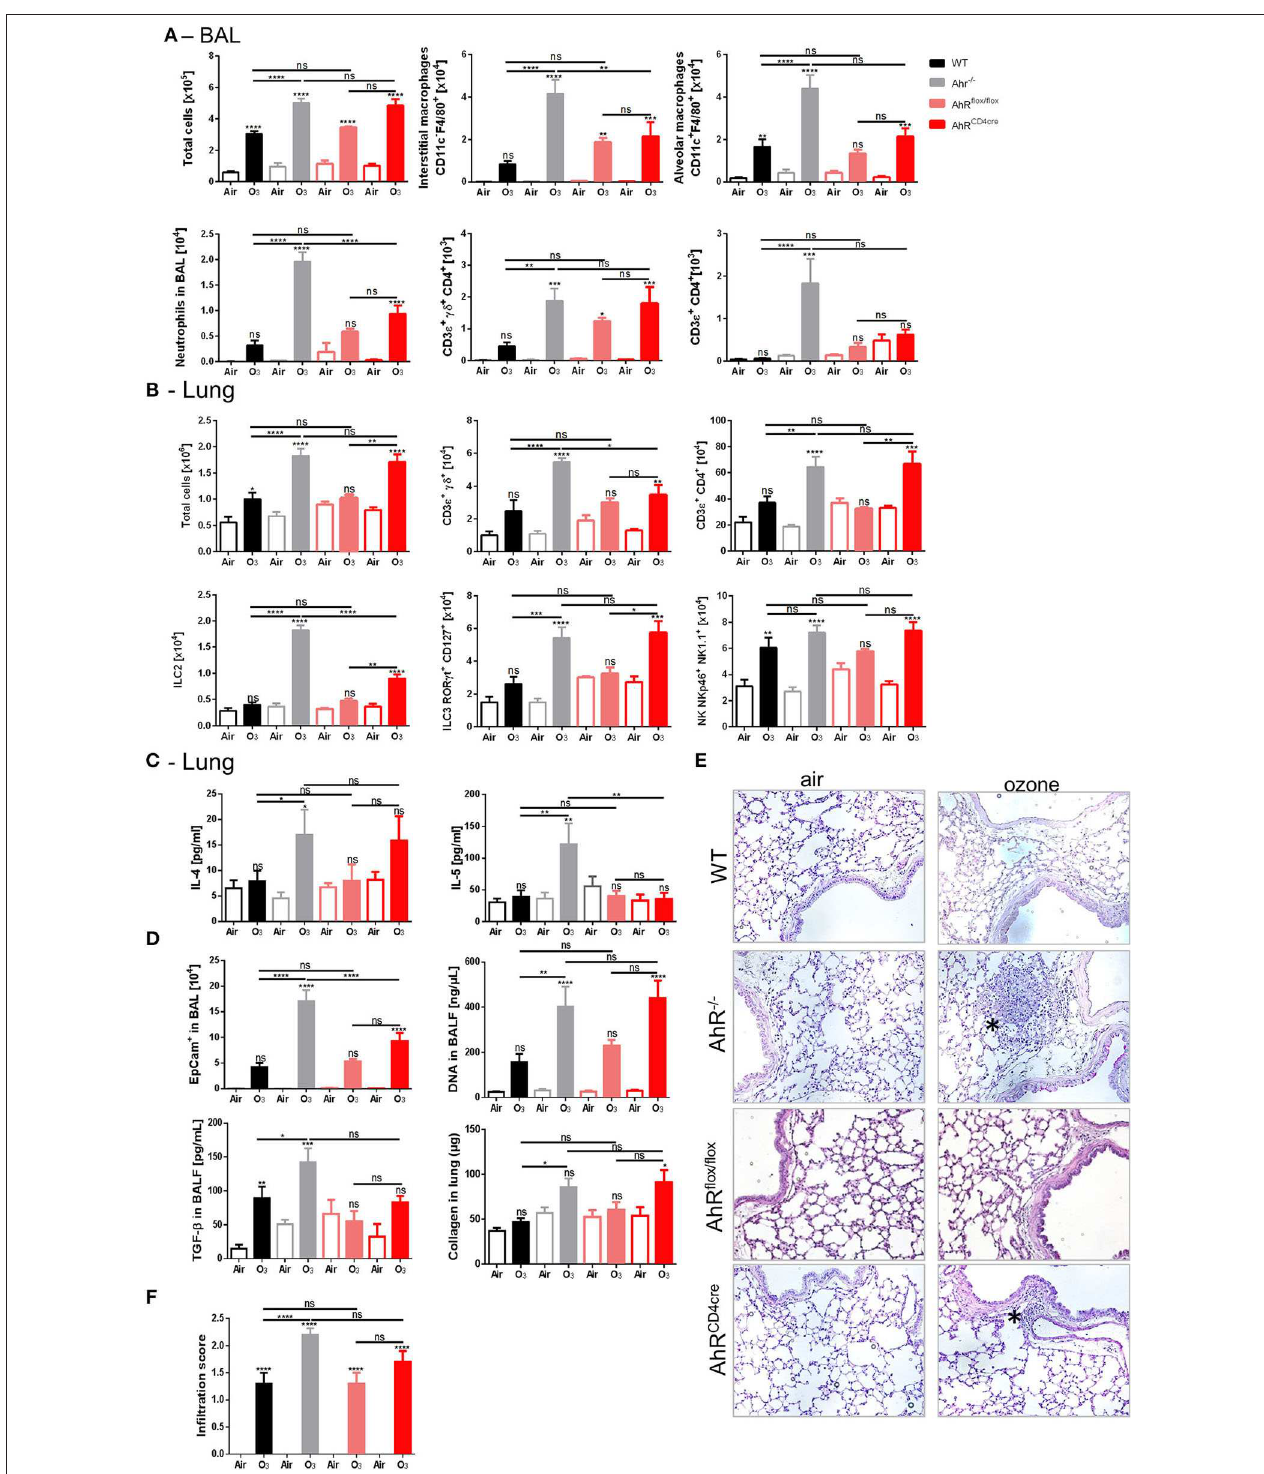
FIGURE 3 | Specific AhR depletion in T cell affects inflammatory parameters. BAL cells recruitment (total cells, macrophages, neutrophils, and T cells) (A) . Lung cells recruitment (total cells, neutrophils, macrophages, ILC2, ILC3, αβ , and γδ T cells) (B) , T H 2 cytokines (IL-4 and IL-5) (C) and remodeling parameters (epithelial cells, DNA, and TGF- β in BAL; collagen in lung) (D) ; lung histology representative pictures (400 × magnification, asterisks show cell infiltration) (E) , and cell infiltration score (F) after ozone exposure in WT and AhR deficient mice. The data are representative for one of two independent experiments with n = 5–6 mice per group. Values are expressed as mean ±